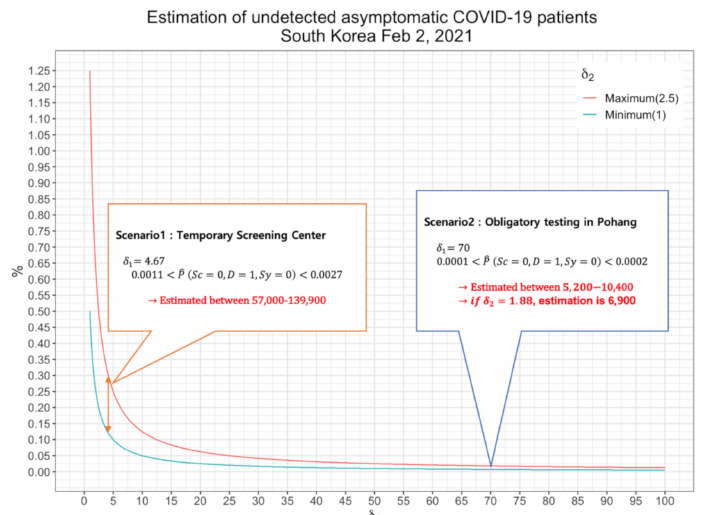
Figure 2. Estimation of undetected asymptomatic COVID-19 cases in South Korea, 2 February 2021 for two different